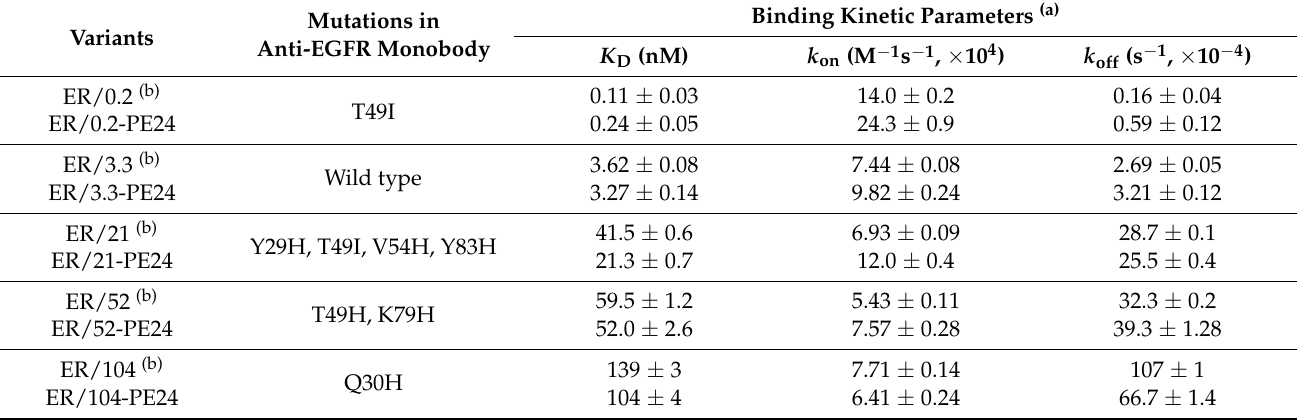
Table 1. Binding kinetics of the interactions between either soluble anti-EGFR monobody variants or PE24-fused ER-PE24 IT variants and immobilized human EGFR-ECD, as measured by bio-layer